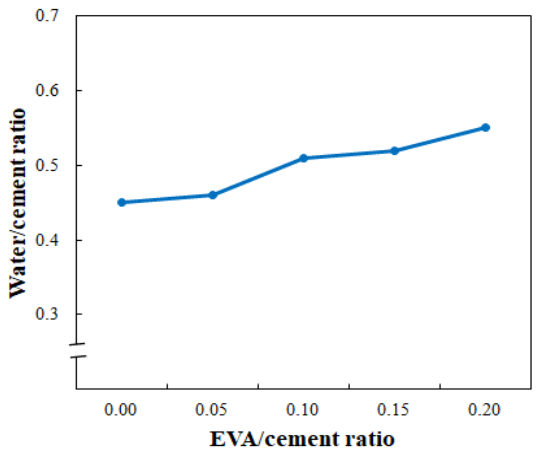
Figure 4. Water / cement ratio versus EVA / cement Figure 4. Water/cement ratio versus EVA/cement ratio. Table 9. Mixture proportions of EVA-modified cementitious mixtures.